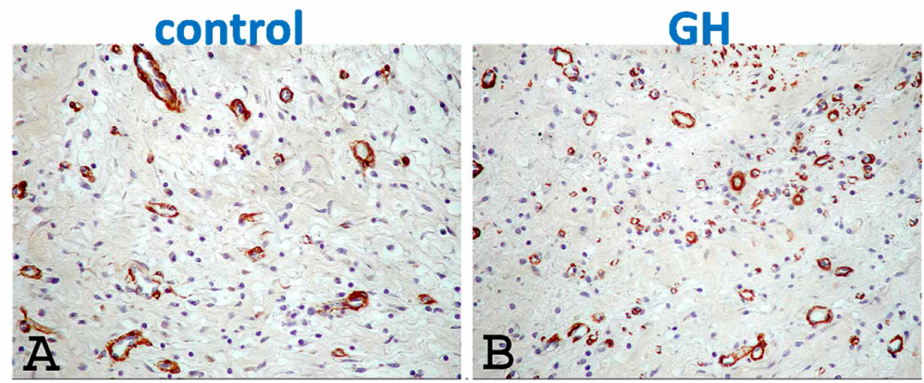
Figure 5. Angiogenesis. Angiogenesis in the peri-infarct area was enhanced after intra-coronary growth hormone (GH) ( B ), compared to controls ( A ). From Mitsi et al., Growth Horm IGF Res. 16 (2006) 93–100 [40], with